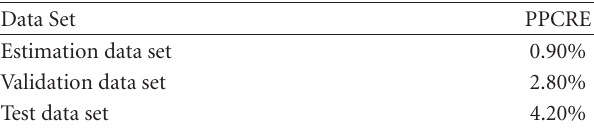
Figure 6: European Union Driving Cycle velocity profile. Table 1: Output estimation errors of the TS fuzzy model for di ff erent data